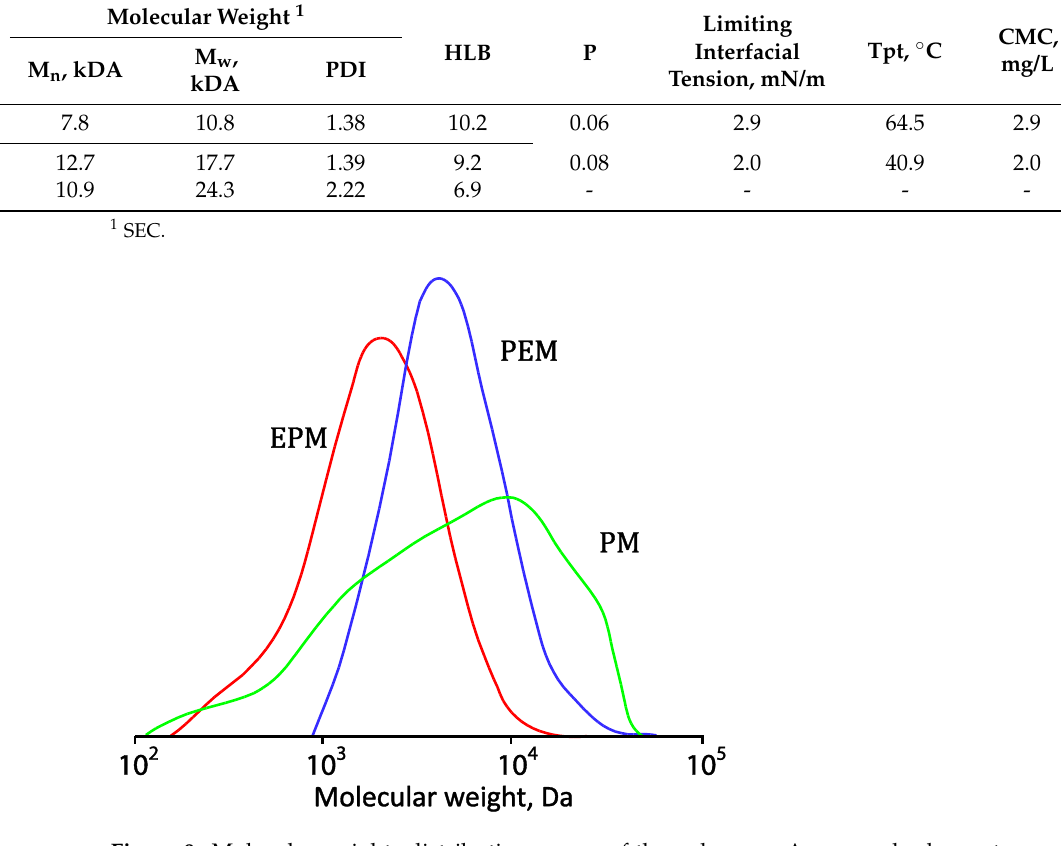
Figure 9. Molecular weights distribution curves of the polymers. An example chromatogram of unpurified pPEM is shown in Figure S4 (Supplementary